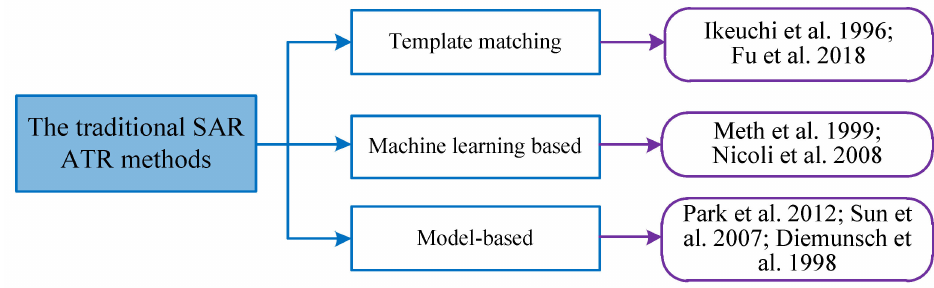
Figure 6. The traditional SAR ATR methods [23–29].